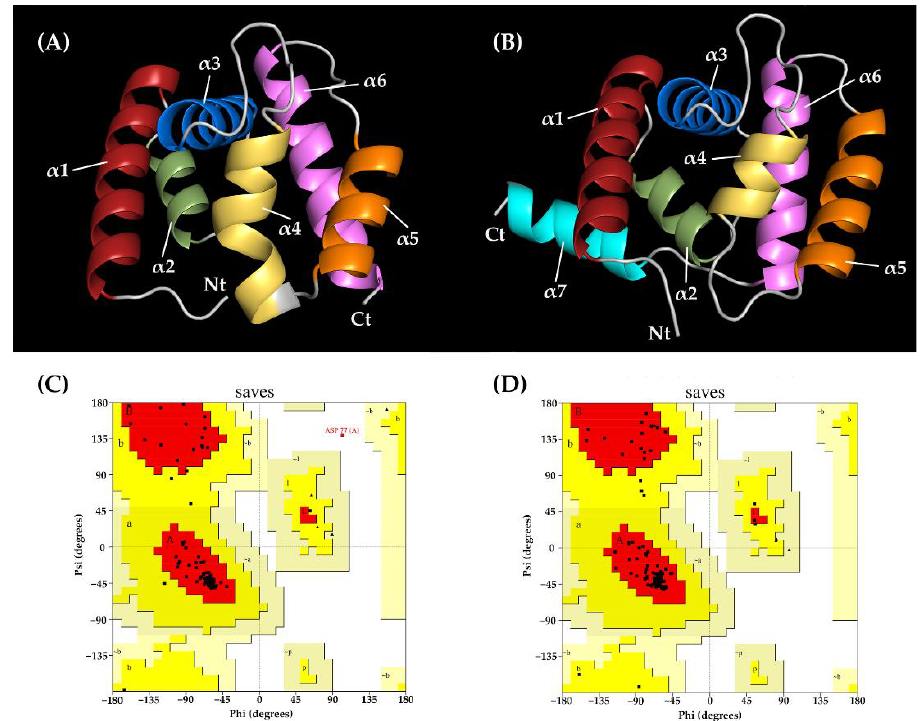
Figure 4. Three-dimensional structure model and Ramachandran plot of EparOBP2. ( A ) The 3D structures of EparOBP2 constructed using SWISS-MODEL. ( B ) The 3D structures of EparOBP2 constructed using trRosetta. ( C ) Ramachandran plot of EparOBP2 model constructed using SWISS-MODEL. ( D ) Ramachandran plot of EparOBP2 model constructed using trRosetta.